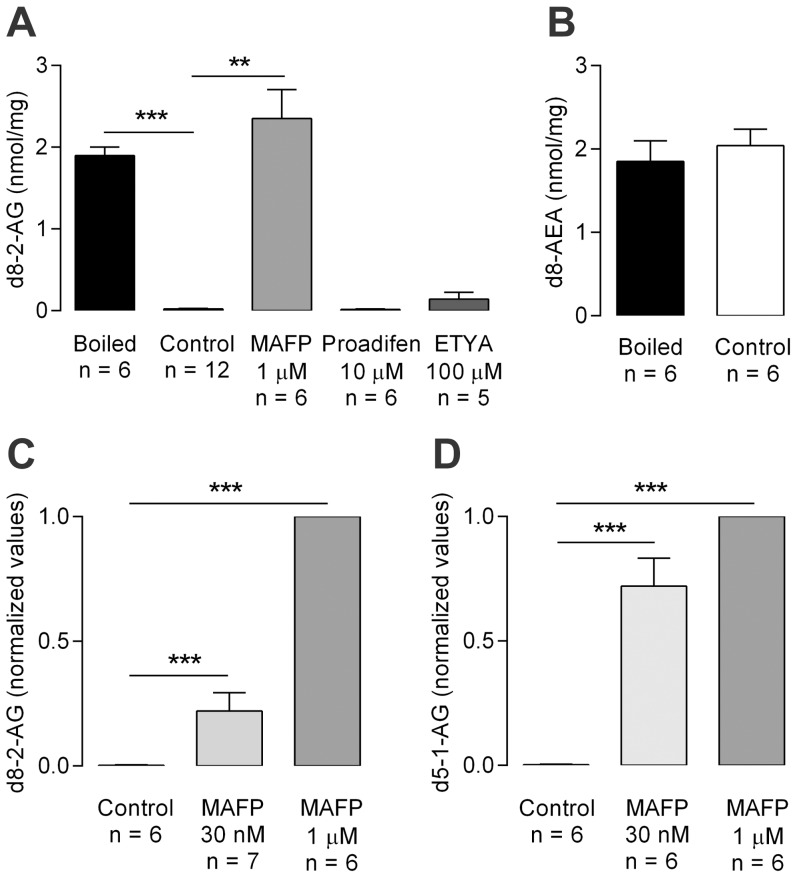
2-arachidonoylglycerol and 1-arachidonoylglycerol, but not anandamide, are metabolized in rat mesenteric artery homogenates.Deuterium(d)-labeled compound at a concentration of 1 µM were each added to the arterial homogenates and the amounts of d8-2-arachidonoyl glycerol (d8-2-AG), d8-anandamide (d8-AEA) and d5-1-arachidonoyl glycerol (d5-1-AG) remaining after 20 min were measured by mass-spectrometry. Enzymatic degradation was confirmed by comparing the amounts of d8-2-AG (A) and d8-AEA (B) in intact (Control) and boiled homogenates. The MAGL inhibitor methylarachidonoyl-fluorophosphonate (MAFP) inhibited the degradation of d8-2-AG (A–C) and d5-1-AG (D). The cytochrome P450 inhibitor proadifen and eicosatetraynoic acid (ETYA), a general inhibitor of arachidonic acid metabolism, did not affect the degradation of d8-2-AG (A). Control experiments were performed in the presence of vehicle (0.1% ethanol) for MAFP, proadifen and ETYA. Data are expressed as mean ± s.e.m. The number of independent experiments (n) is given in the figure. Kruskal-Wallis one-way ANOVA followed by Dunn's post hoc test was used for comparing groups of data. **P<0.01, ***P<0.001.